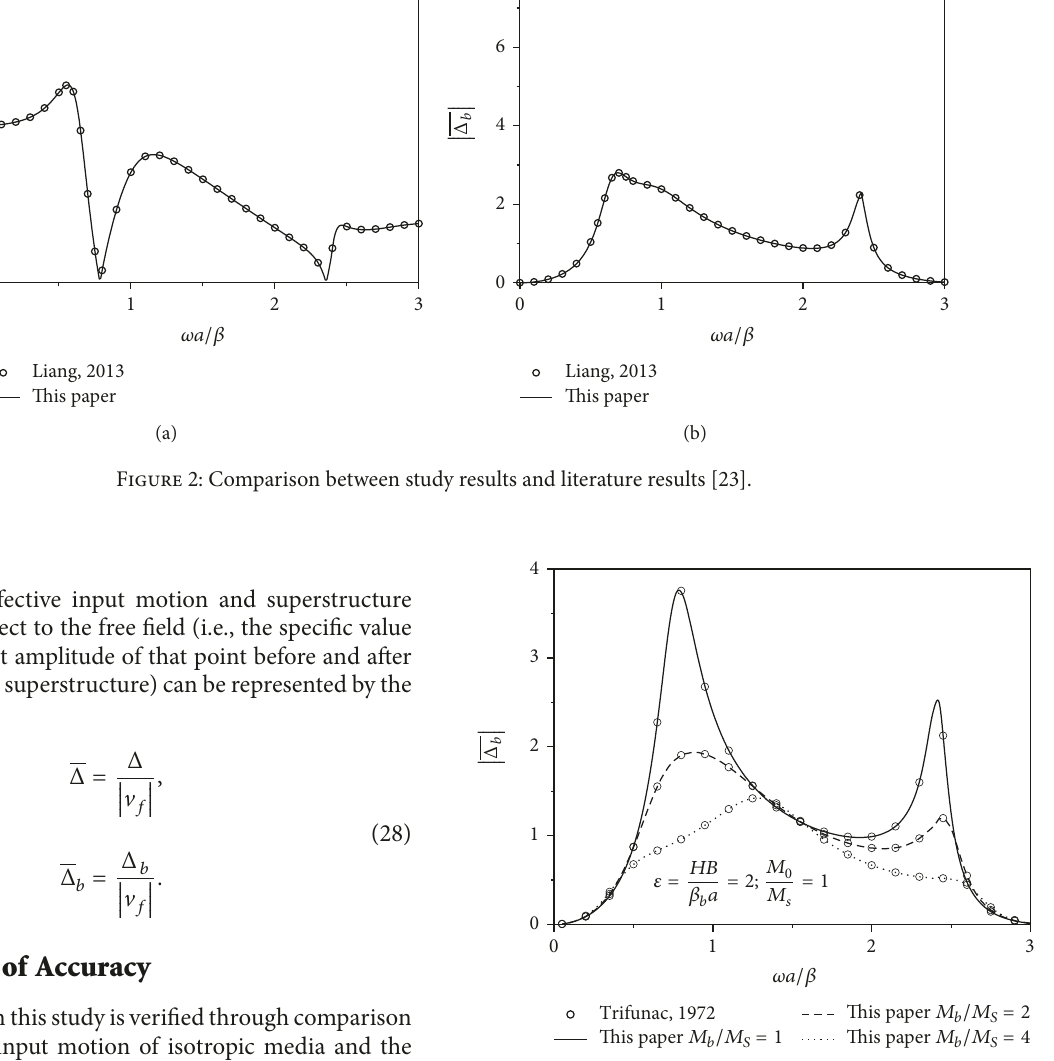
Figure 3: Comparison between study results and literature results